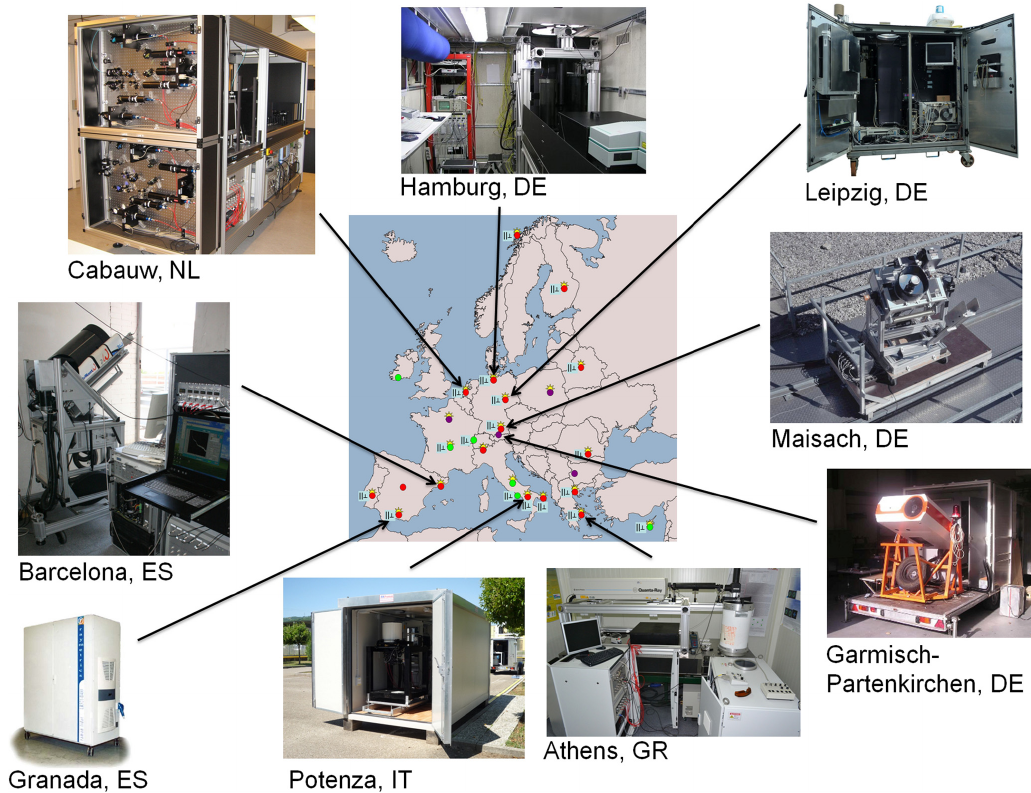
Figure 3. Pictures of a selection of individual lidar systems that are part of